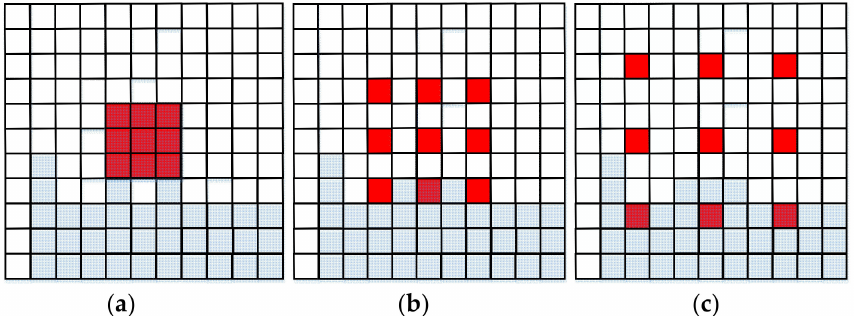
Figure 4. Schematic of dilated convolution. Red pixels represent non-zero weight values, white pixels represent zero weight values, and the matrix composed of red pixels is the size of the receptive field: ( a ) d = 1, dilation convolution with a receptive field size of 3 × 3, the same as that of the standard convolution; ( b ) d = 2, dilation convolution with a receptive field size of 5 × 5; ( c ) d = 3, dilation convolution with a receptive field size of 7 ×